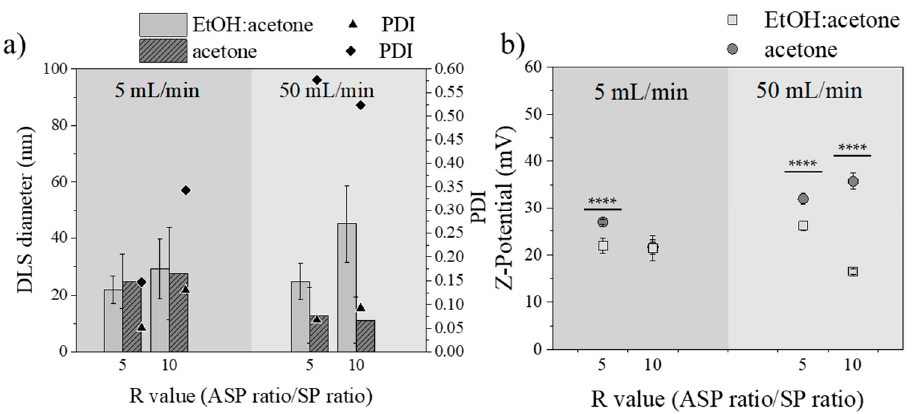
Figure 6. ( a ) DLS diameter of Eudragit ® RS100 5% (w/v) EtOH:acetone (light gray) and Eudragit ® RS100 5% (w/v) acetone (dark gray) of different R values and total flows synthesis (n = 3). Polydispersity index (PDI) of Eudragit ® RS100 5% (w/v) EtOH:acetone ( ▲ ) and Eudragit ® RS100 5% (w/v) acetone ( ♦ ), ( b ) Z-potential of Eudragit ® RS100 5% (w/v) EtOH:acetone (light gray ■ ) and Eudragit ® RS100 5% (w/v) acetone (dark gray ● ) (**** p < 0.0001). Table 6. Mean diameter and PDI comparison between batch and continuous flow production: effect of type of solvent in the